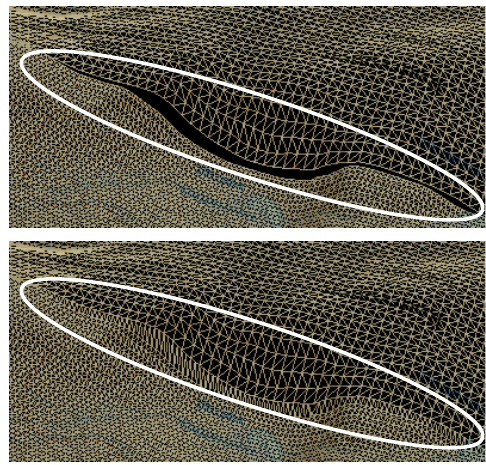
Figure 9: Realtime stitching of terrain meshes at different levels of detail. for each tile is selected using the main virtual camera. Two addi- tional virtual cameras are created, offset slightly left and right of the main camera. This is done to avoid selecting different levels of detail for textures and terrain meshes for the two viewpoints. The two renderings are done at half the horizontal resolution of the regular viewport, using the virtual cameras for the left and right eye.